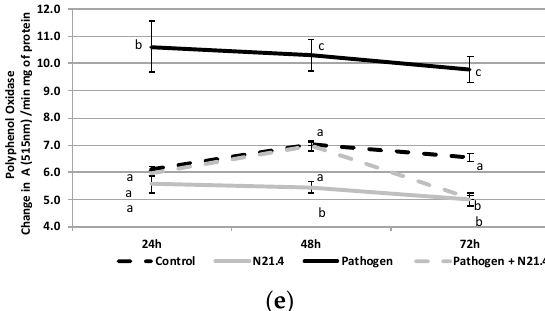
Figure 5. Activity of reactive oxygen species scavenging enzymes of 6-week old tomato plants inoculated with P. fluorescens N21.4 and non-inoculated controls in the priming phase and in the post-challenged priming state after inoculation with the leaf spot pathogen Xanthomonas campestris sampled at 24 h, 48 h and 72 h after challenge. ( a ) Superoxide dismutase (SOD), ( b ) Ascorbate peroxidase (APX), ( c ) Glutathione reductase (GR), ( d ) Guaiacolperoxidase (GPX), ( e ) Polyphenol oxidase (PPO). Control: Non treated or challenged plants (black broken line). N21.4: plants treated with Pseudomonas fluorescens (grey solid line). Pathogen: plants challenged with the leaf spot pathogen Xanthomonas campestris (black solid line). Pathogen + N21.4: plants treated with Pseudomonas fluorescens N21.4 and challenged with the leaf spot pathogen Xanthomonas campestris (grey broken line). Bars indicate standard errors ( n = 3). Different letters indicate significant differences ( α = 0.05) between treatments for each time point.